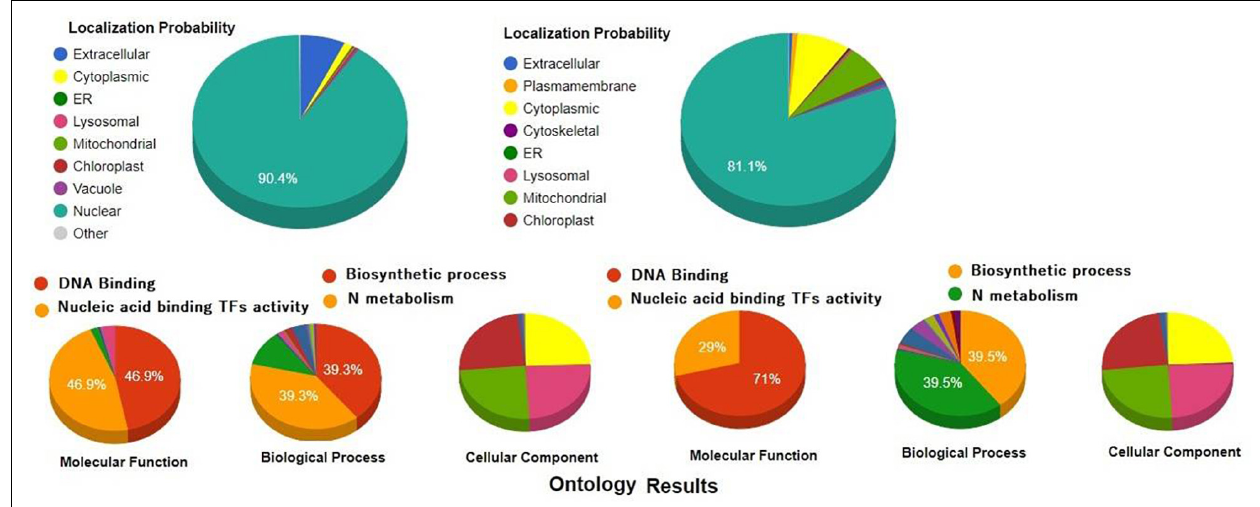
FIGURE 2 | Functional annotation of WRKY and NAC proteins. These functional annotation were retrieved from Cello2GO server and were structured around gene ontologies like biological process, molecular function, and cellular component along with their localization probability. It is to be noted that both WRKY and NAC proteins have diversified function with more specifically targeted to DNA binding or Nucleic acid binding transcriptional factor